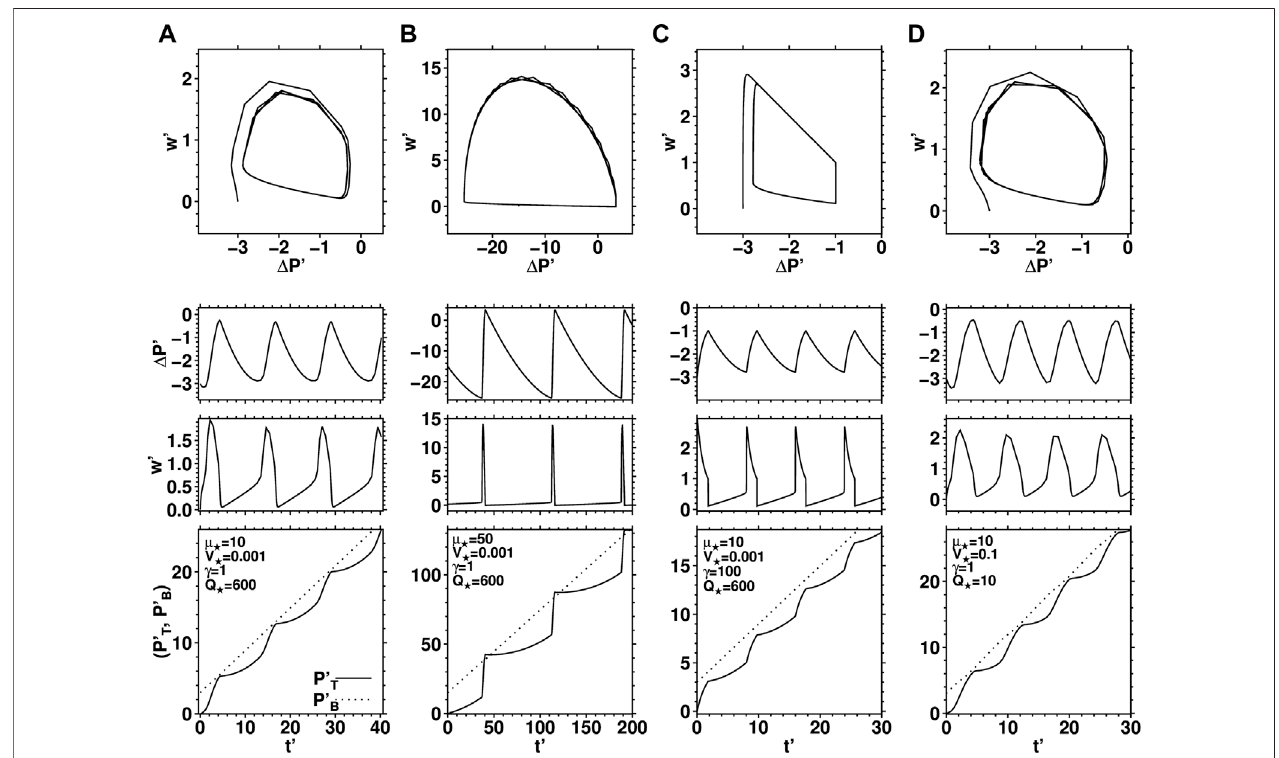
FIGURE8| Nonlinearpressureoscillationoftheidealizedphysicalmodelgovernedby Eqs9a , 9b .Toppanelsrepresentthephaseportraitsofthesimulationinthe ( Δ P ′ , w ′ ) plane. Subsequent panels represent, from top to bottom: Time series of Δ P ′ ( t ′ ); time series of w ′ ( t ′ ); and time series of P B ′ ( t ′ ) (dotted) and P T ′ ( t ′ ) (solid). The model solutions were computed using the following sets of parameters: (A) ( μ + , V + , γ , Q + ) = (10, 0.001, 1, 600); (B) ( μ , V + , γ , Q + ) = (50, 0.001, 1, 600); (C) ( μ + , V + , γ , Q + ) = (10, 0.001, 100, 600); (D) ( μ + , V + , γ , Q + ) = (10, 0.1, 1, 10). All variables and parameters are expressed in dimensionless form.